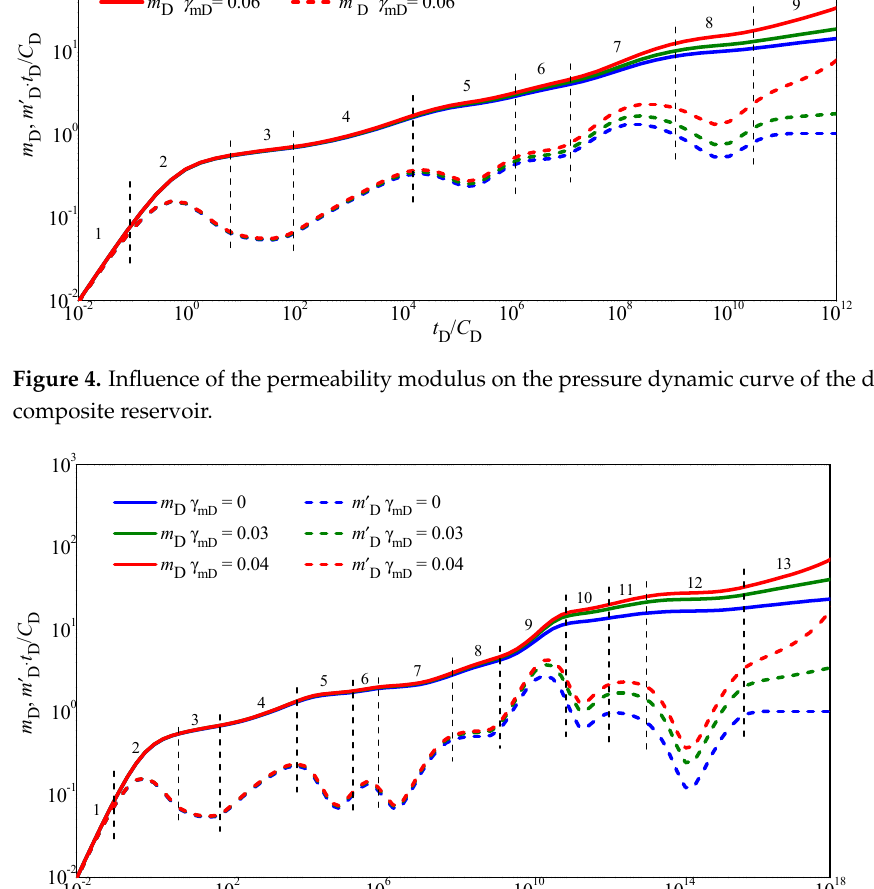
t D / C D Figure 6. Influence of the inner–zone cave–fracture interporosity flow coefficient on the pressure type curve. As demonstrated by Figure 7, the influence of the interporosity flow coefficient be- tween the matrix and fracture of the outer zone ( λ m2 ) on the pressure derivative type curve is most mirrored in stage 12. With the decrease in λ m2 , the “dip” gradually moved to the right, that the later the occurrence of the interporosity flow. This feature is similar to the influence of λ v1 on the pressure derivative type curve but at different stages. The flow